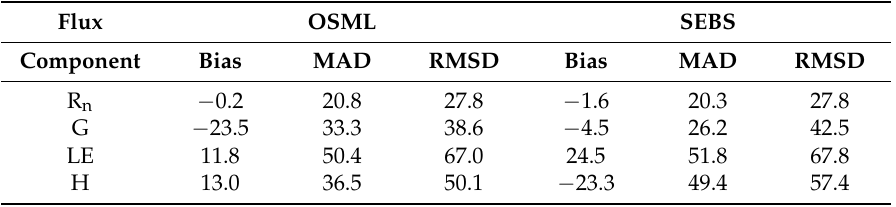
Table 5. Statistics of validating OSML and SEBS using tower-based observations (W/m 2 ). Flux OSML SEBS Component Bias MAD RMSD